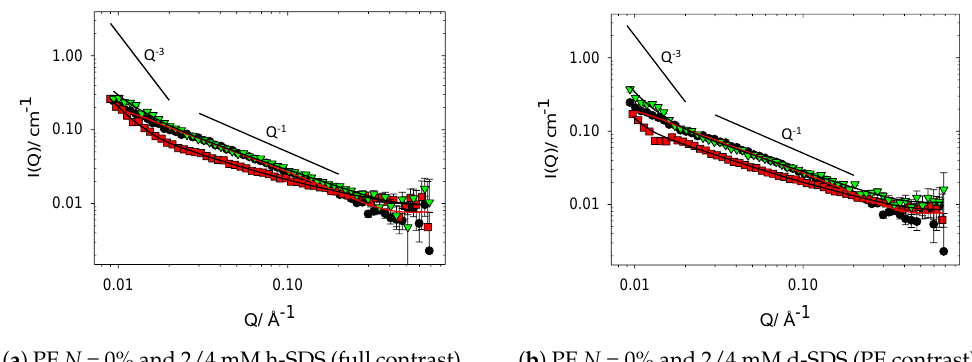
Figure 3. SANS profiles from binary mixtures containing 1 wt% HEC polymer and h-SDS (full contrast) or d-SDS (PE contrast). Symbols: circles, no SDS; squares, 2 mM SDS; down triangles, 4 mM SDS. The solid lines show Q − 1 and Q − 3 behaviour. Table 2. Fitted structural parameters for binary mixtures containing 1 wt% unmodified polymer and h-SDS (full contrast) or d-SDS (PE contrast). R is radius and L is length. Degree of Modification